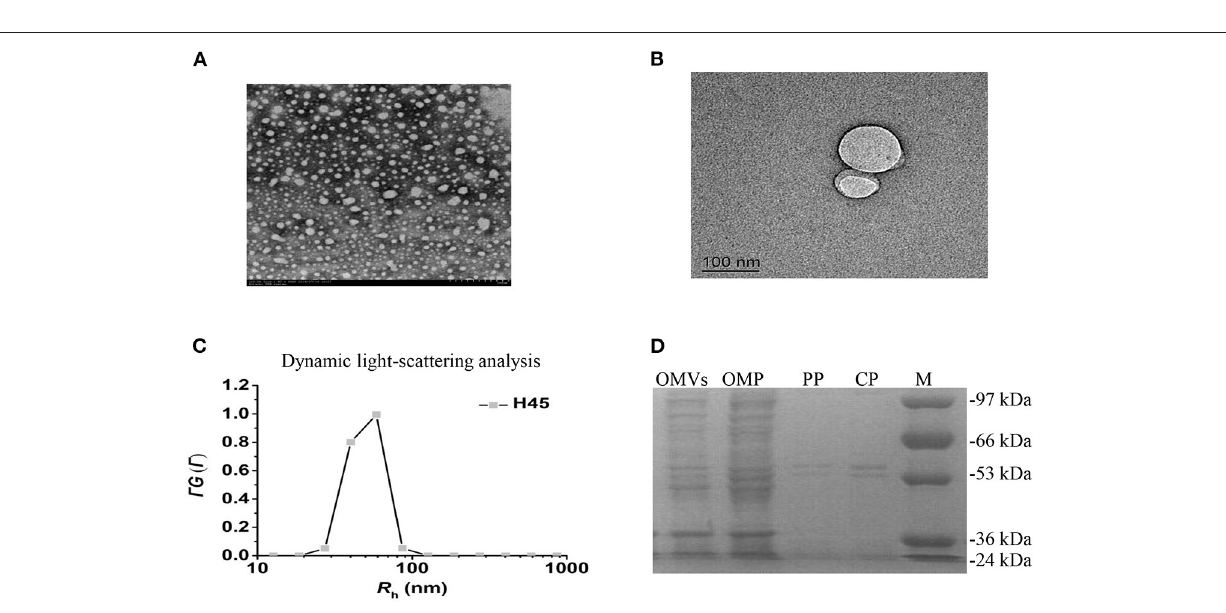
= 356), cytoplasmic membrane ( n = 78), periplasmic ( n =